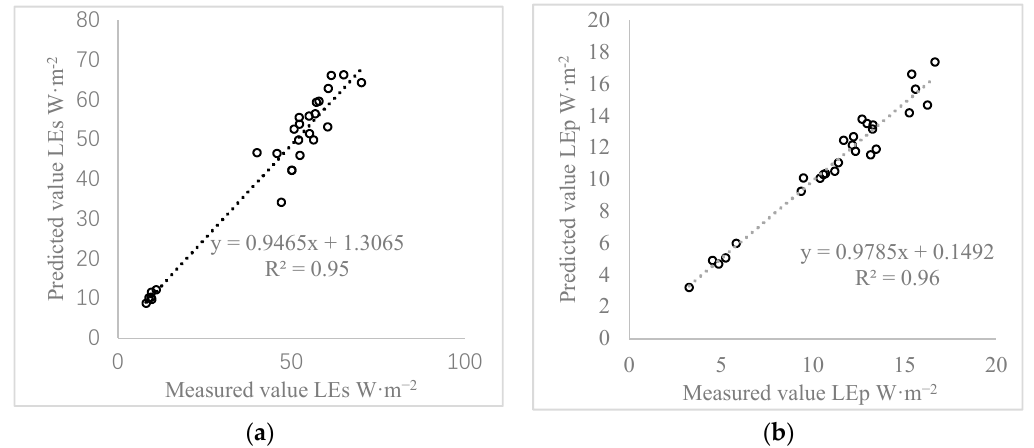
(cid:0) (cid:1) R 2 were 0.95